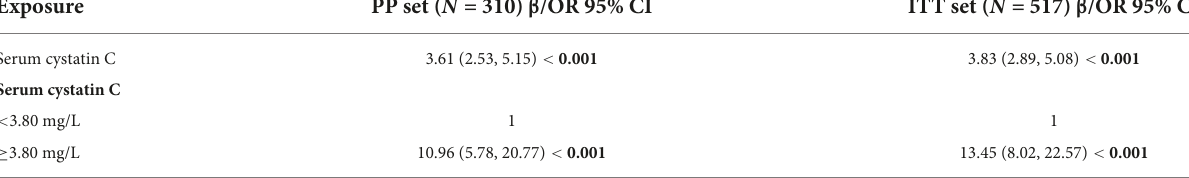
TABLE 4 The logistic regression serum cystatin C and its Youden’s index cut-off point.